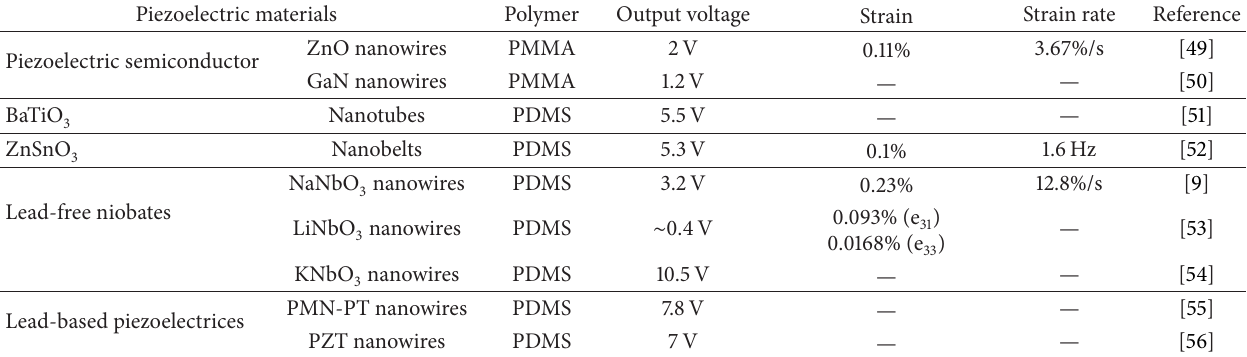
Table 2: The energy conversion performance of the reported nanogenerators based on nanowire composite. Piezoelectric